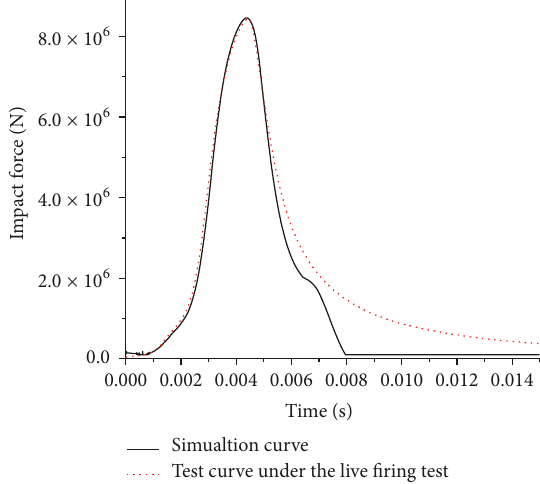
Figure 10: Shock force curve comparison generated by the high- power hydraulic shock wave simulator and live firing test, respec-